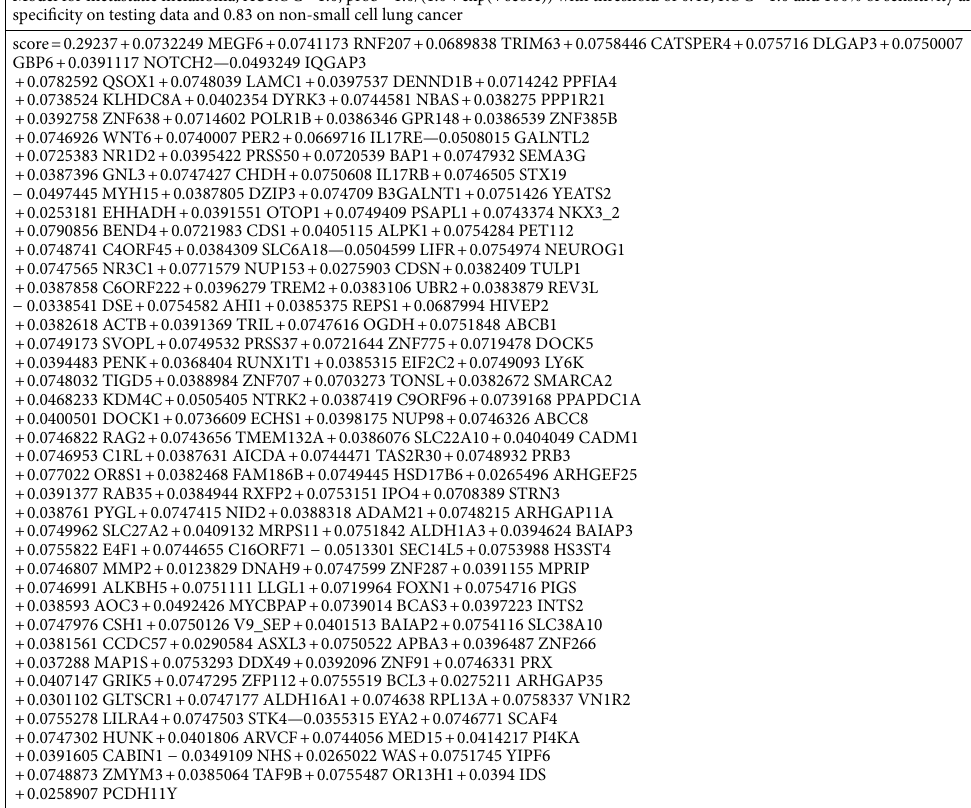
Table 2. 161-gene tumor mutational burden (TMB) model: gene mutations and coefficients included in the final least absolute shrinkage and selection operator (LASSO) model.